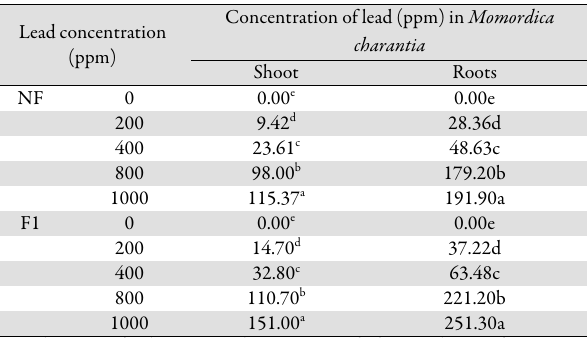
Table 3. Elemental deposition of lead (ppm) in the shoots of Momordica charantia Lead